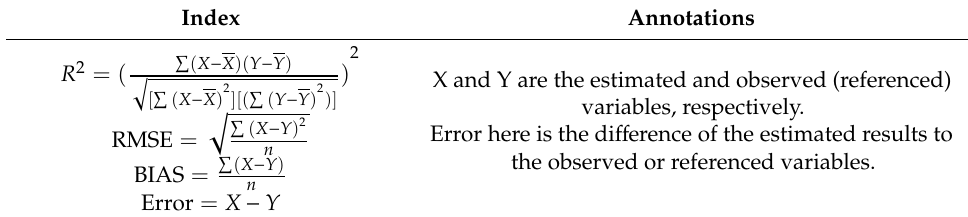
Table 2. Calculating equations of evaluation